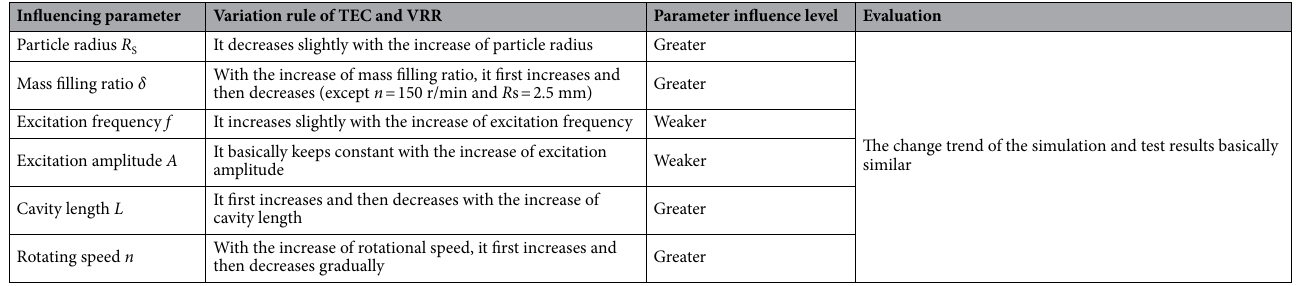
Table 4. Variation rule of TEC and VRR at n = 90